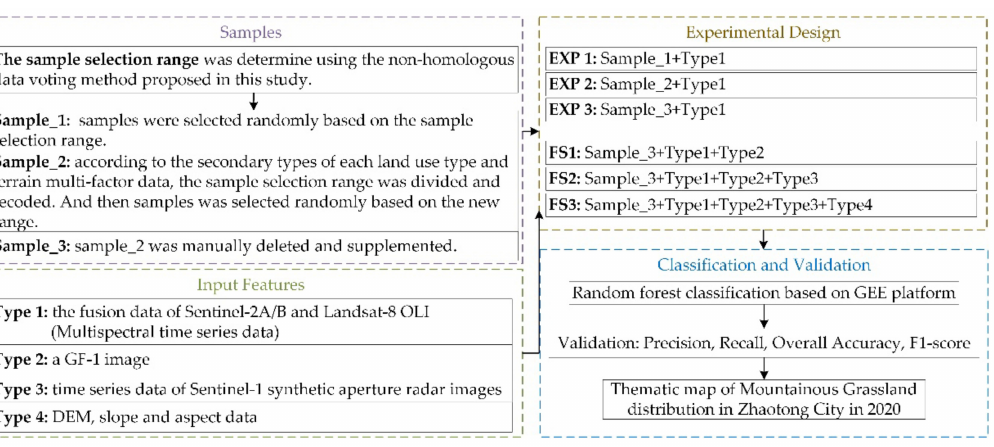
Figure 3. Flow chart of the remote sensing grassland identification